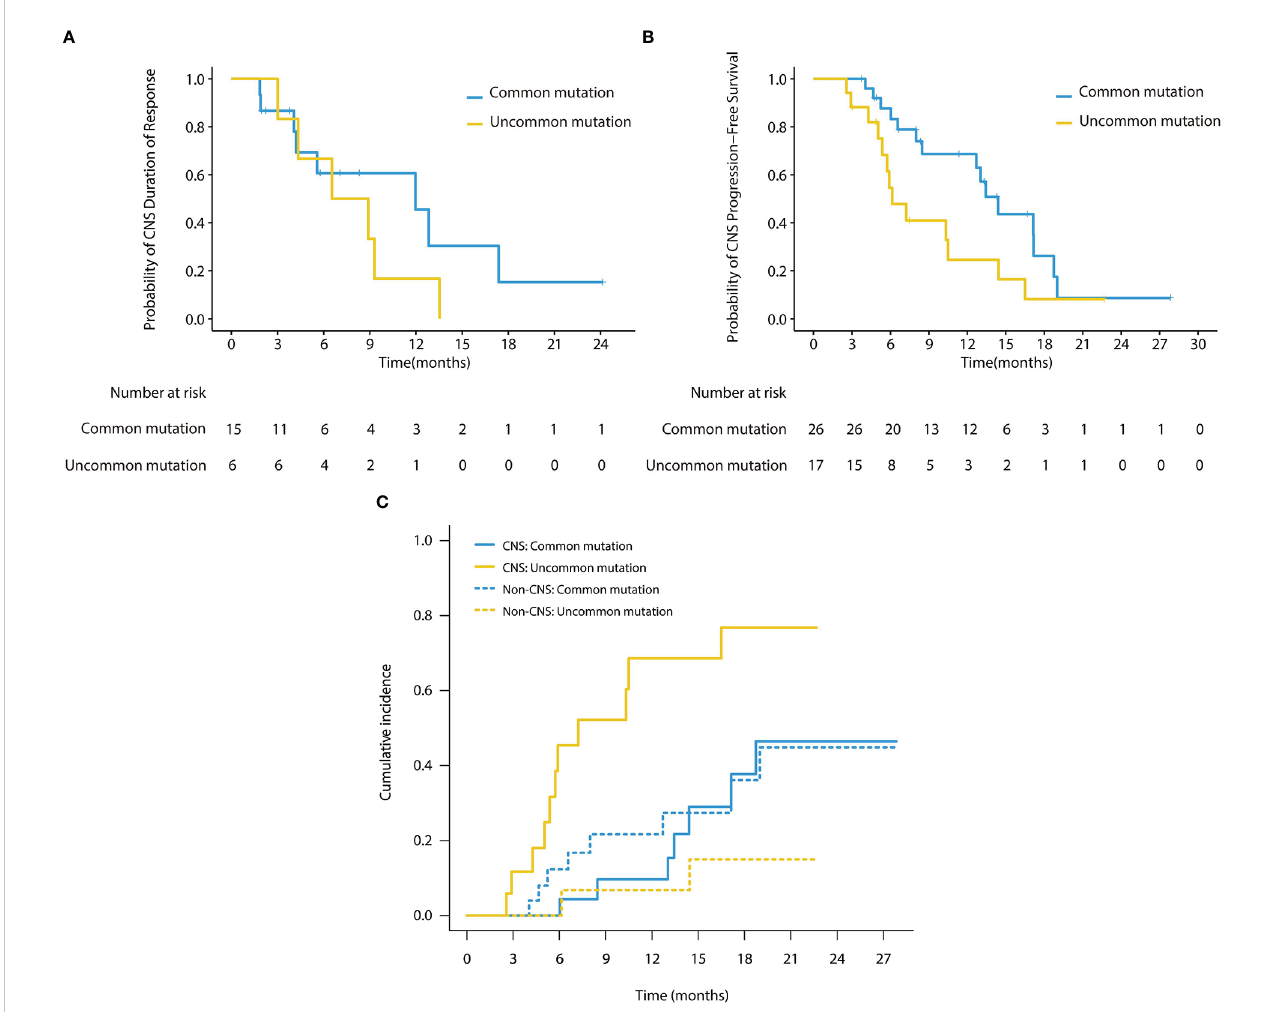
FIGURE 4 (A) Kaplan-Meier survival curves of CNS DoR in subgroup analysis (cFAS). The CNS mDoR was 12.0 months (95% CI, 4.1 - 19.9 months) in patients with common mutations and 6.5 months (95% CI, 1.1 - 12.0 months) in patients with uncommon mutations (HR, 0.57; 95% CI, 0.19 - 1.71; p = 0.31). (B) Kaplan-Meier survival curves of CNS PFS in subgroup analysis (cFAS). The CNS mPFS was 14.4 months (95% CI, 12.0 - 16.8 months) in patients with common mutations and 6.1 months (95% CI, 4.3 - 8.0 months) in patients with uncommon mutations (HR, 0.47; 95% CI, 0.22 - 1.00; p = 0.045). (C) Cumulative incidence of CNS failure in patients with baseline brain metastases. Patients with common mutations showed a signi fi cantly lower cumulative incidence of CNS failure compared with those with uncommon mutations ( p = 0.0026), with the estimated probability of CNS progression at 12 months of 9.7% and 68.6%, respectively.